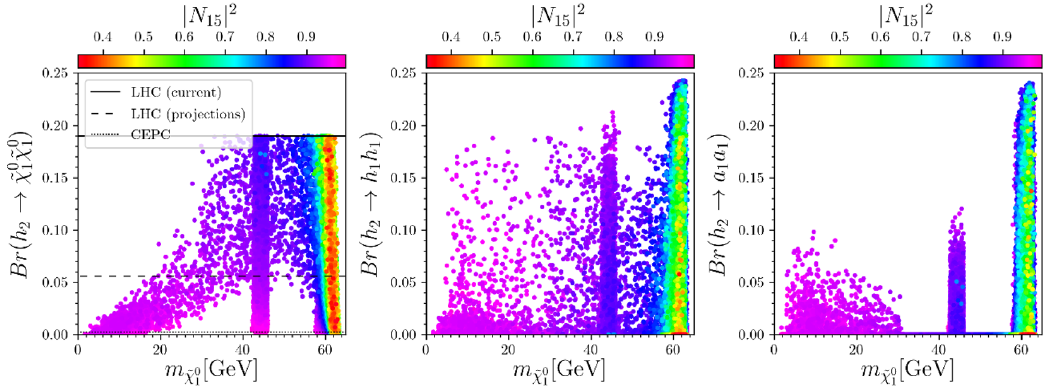
Figure 6 . The surviving samples in the Higgs invisible decay Br ( h 2 ! ~ (cid:31) 0 Br ( h 2 ! h 1 h 1 ) (middle) and Br ( h 2 ! a 1 a 1 ) (right) versus the LSP mass m Colors indicate the singlino component j N 15 j 2 in the LSP ~ (cid:31) 0 dash-dotted and dotted lines indicate the Higgs invisible decay upper limit from the current LHC 19% [7], future HL-LHC 5 : 6% [89], and CEPC 0 : 24% [90] respectively. Samples with smaller j N 15 j 2 are projected on top of the larger